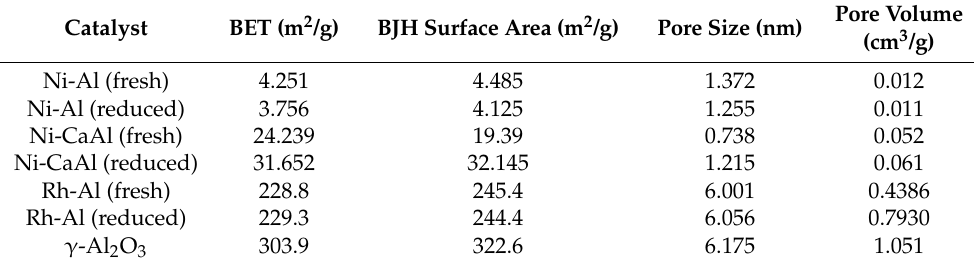
Table 2. Morphological properties of Ni and Rh packed bed catalysts.